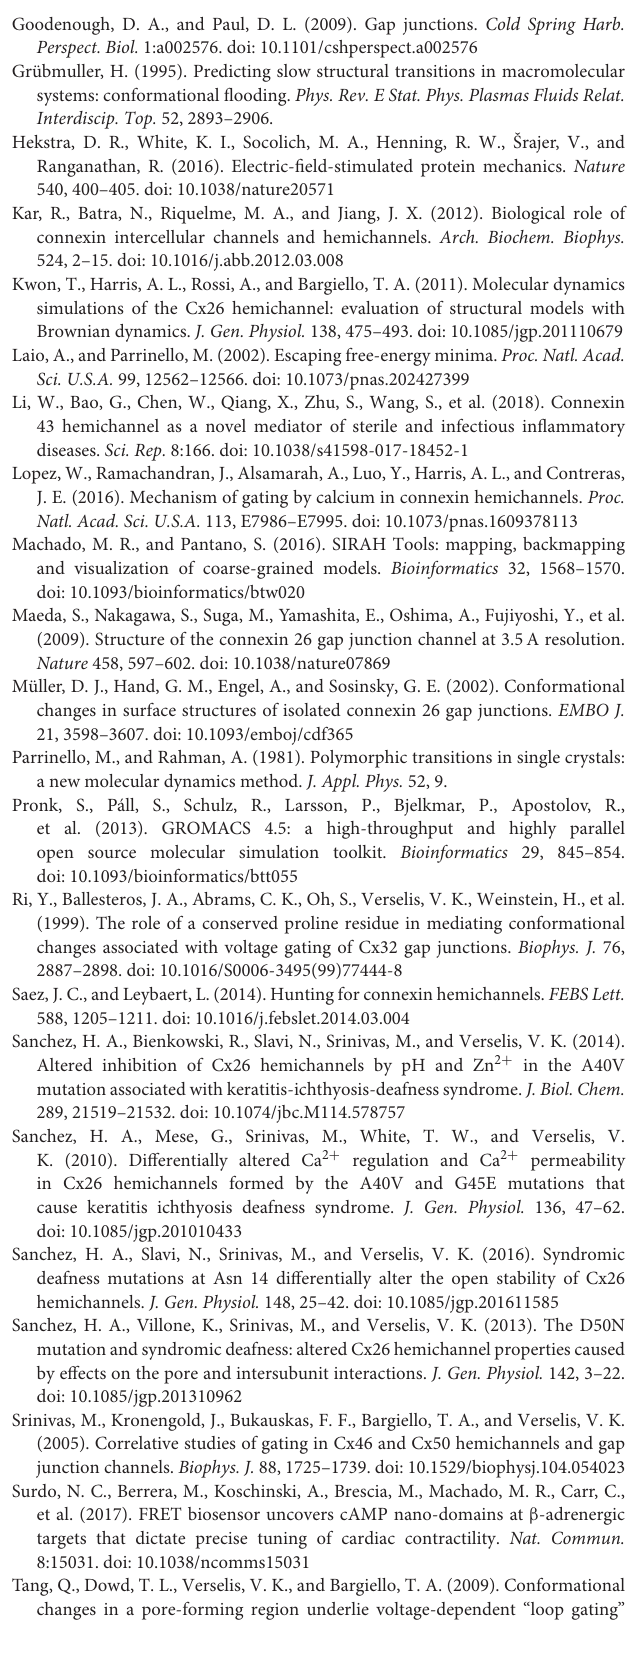
Frontiers in Molecular Neuroscience |